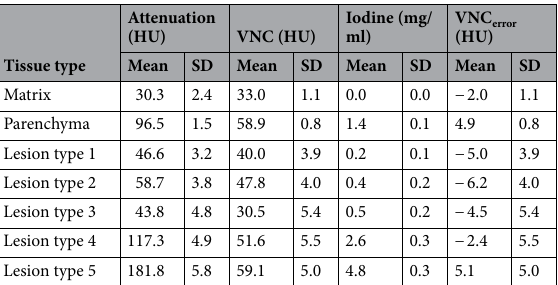
Table 2. Overall measurement results for attenuation, VNC, iodine and VNCerror for each tissue type.